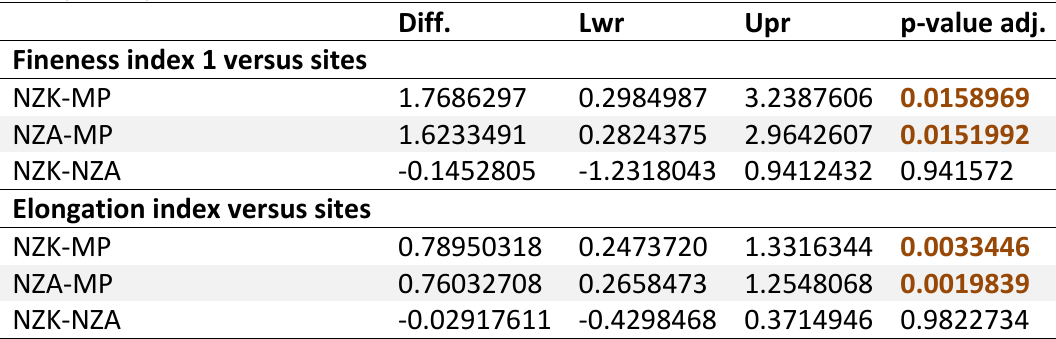
Table 4. Results of the post-hoc Tukey HSD tests conducted on fineness index 1 and elongation index for the Lupemban point assemblages. The significant values are in bold. diff. : difference in the observed means, lwr : lower end point of the interval, upr : upper end point of the interval, p-value adj : p-value after adjustment for the multiple comparisons.